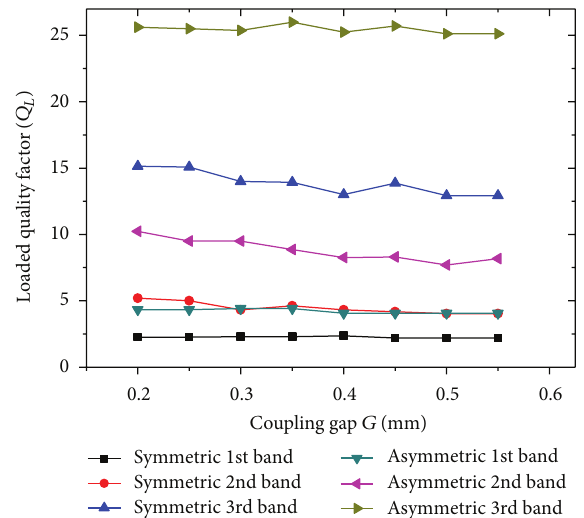
Figure 7: Variation of the loaded quality factor (𝑄 𝐿 ) of the symmetric and asymmetric TBBSFs with the corresponding folding coupling gap 𝐺